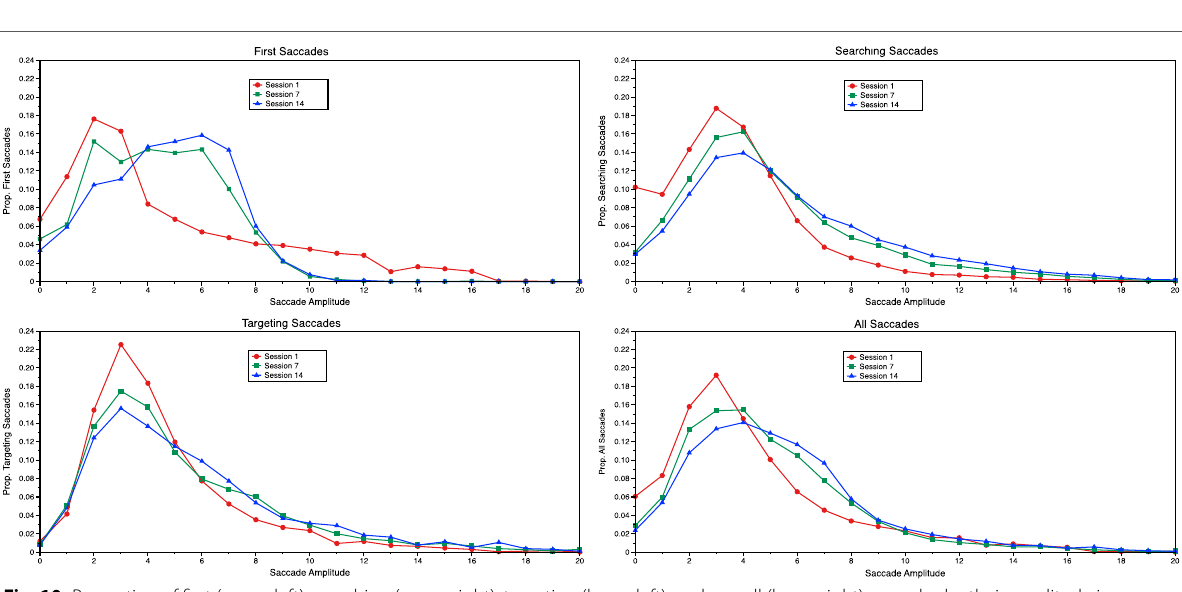
Fig. 10 Proportion of first (upper left), searching (upper right), targeting (lower left), and overall (lower right) saccades by their amplitude in sessions 1 (red circles), 7 (green squares), and 14 (blue